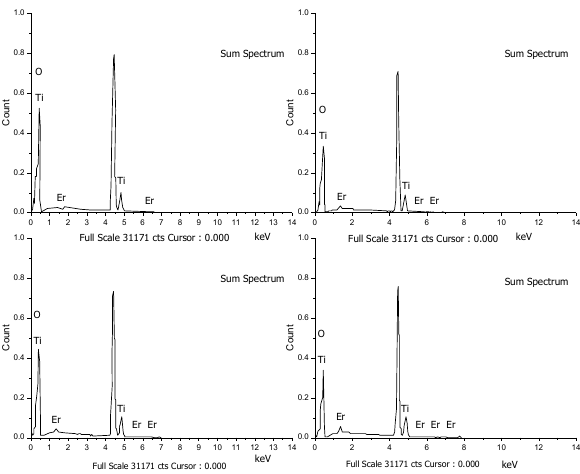
Figure 3. EDX micrographs of the synthesized samples.